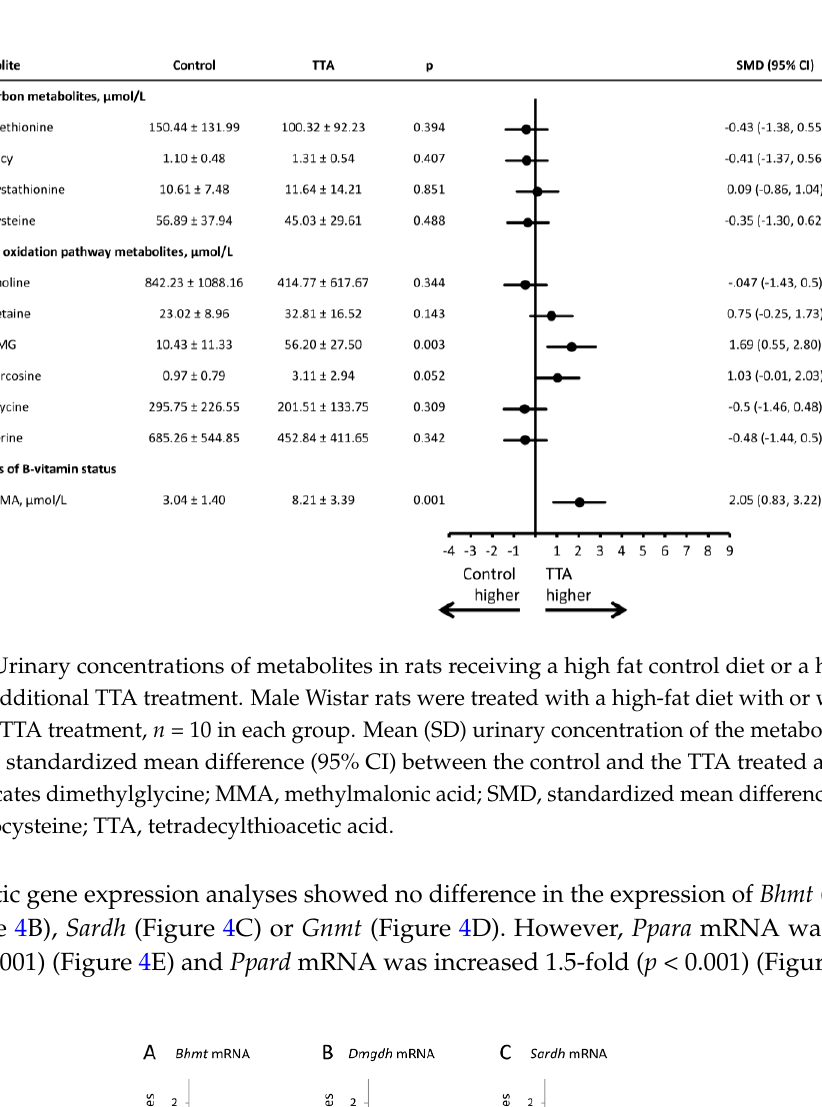
5 of 13 Figure 2. Plasma concentrations of metabolites in rats receiving a high fat control diet or a high fat diet with additional TTA treatment. Male Wistar rats were treated with a high-fat diet with or without